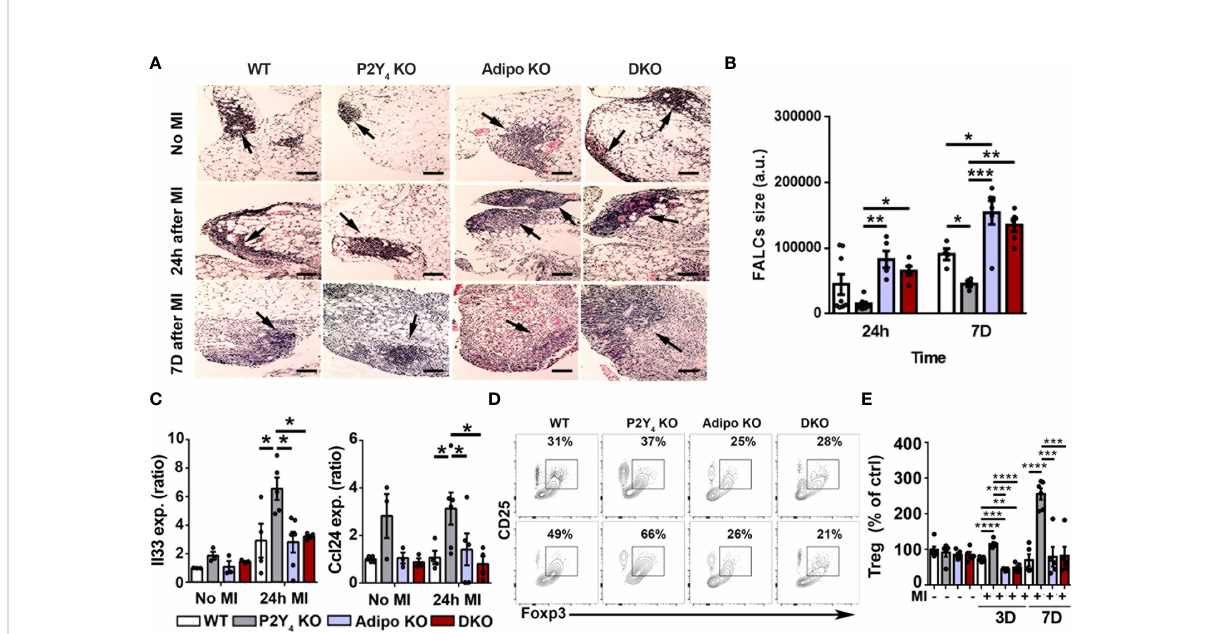
FIGURE 4 Lymphoid cluster reduced expansion and T cell polarization in ischemic PAT of P2Y 4 mice. (A) Representative pictures of hematoxylin/eosin staining showing FALCs (lymphoid clusters; some are indicated with black arrows) observed in PAT of WT, P2Y 4 KO, Adipo KO and DKO mice, with or without MI (200x magni fi cation) (scale bar = 50 m m). (B) Quanti fi cation of mean FALCs size detected in PAT 24 hours (24h) or 7 days (7D) after MI (a.u., arbitrary units) (n = 5). (C) mRNA level quanti fi cation of Il33 and Ccl24 expression in PAT of WT, P2Y 4 KO, Adipo KO and DKO mice, without MI or 24h post-MI (relative expression normalized to Rpl32 housekeeping gene)(n = 3-6). (D) CD25-Foxp3 dot plots representing the gating used for fl ow cytometry quanti fi cation of regulatory lymphocyte population in PAT of mice without MI (upper dot plots) and 7 days post-MI (lower dot plots). (E) Percentage of regulatory lymphocytes in WT, P2Y 4 KO, Adipo KO and DKO PAT from mice without MI, and 3 days (3D) or 7 days (7D) after MI (normalized to Treg level in control (ctrl) WT PAT) (n = 5-6). Data represent mean ± SEM. *p < 0.05; **p < 0.01; ***p < 0.001; ****p <